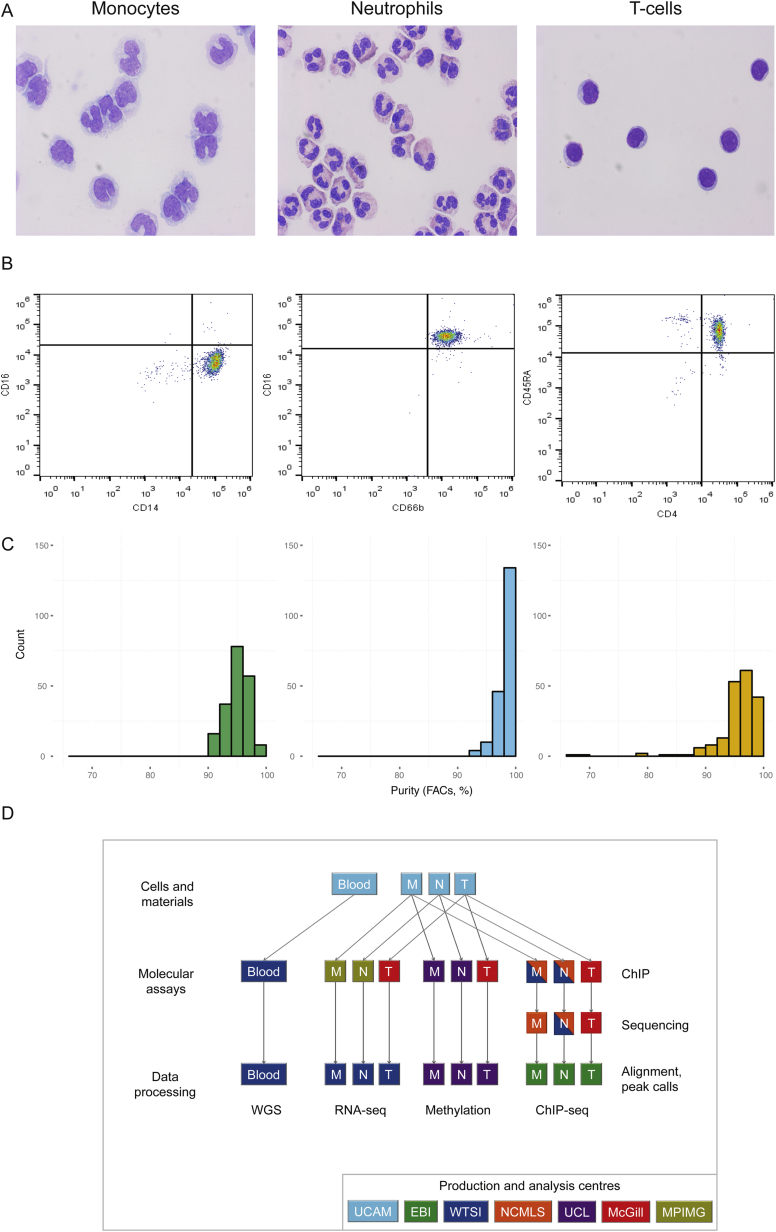
Sample Collection, Related to Figure 1(A) Morphological assessment of purified cell preparations. Cells were fixed to slides using a Cytospin and stained using Wright-Giemsa stain prior to photographing using 100x magnification.(B) Examples of neutrophil, monocyte and naive CD4+ T cell staining to assess purity of cell preparations.(C) Histogram of cell purity based on FACs analysis in three cell types.(D) Details of data production centers. Data from this project were produced in different institutes as detailed here: University of Cambridge- UCAM, European Bioinformatics Institute- EBI, Wellcome Trust Sanger Institute- WTSI, Nijmegen Centre for Molecular Life Sciences- NCMLS, University College London- UCL, McGill University- McGill, Max Planck Institute for Molecular Genetics- MPIMG. Peripheral blood mononuclear cells (PBMC) were isolated from donors at UCAM and from these Monocytes (M), Neutrophils (N), naive CD4+ T cells (T) were extracted, with a further aliquot used as a source of genomic (g)DNA samples. gDNA was shipped to the WTSI for sequencing, the monocyte/neutrophil samples were divided between MPIMG/UCL/WTSI+NCMLS for RNA-seq, DNA methylation sequencing (Methylation) and ChIP-seq respectively and the naive CD4+ T cells sent to McGill for RNA-seq/Methylation/ChIP-seq. In addition to this three samples from each institute/assay set were sent to the reciprocal institute for cross-center validation purposes (eg RNA-seq assays were carried out on the same three samples at both MPIMG and McGill etc.). Data processing/analysis was carried out at WTSI for WGS and RNA-seq, UCL for DNA methylation sequencing and EBI for ChIP-seq.